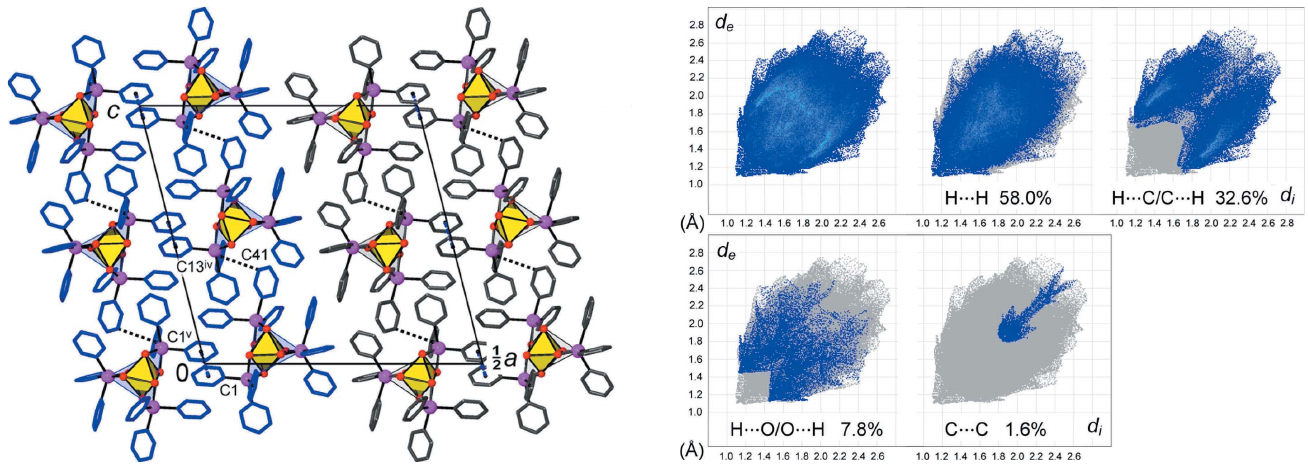
Figure 5 The overall two-dimensional fingerprint plot for the title compound, and those delineated into H (cid:2)(cid:2)(cid:2) H (58.0%), H (cid:2)(cid:2)(cid:2) C/C (cid:2)(cid:2)(cid:2) H (32.6%), H (cid:2)(cid:2)(cid:2) O/ O (cid:2)(cid:2)(cid:2) H (7.8%) and C (cid:2)(cid:2)(cid:2) C (1.6%)